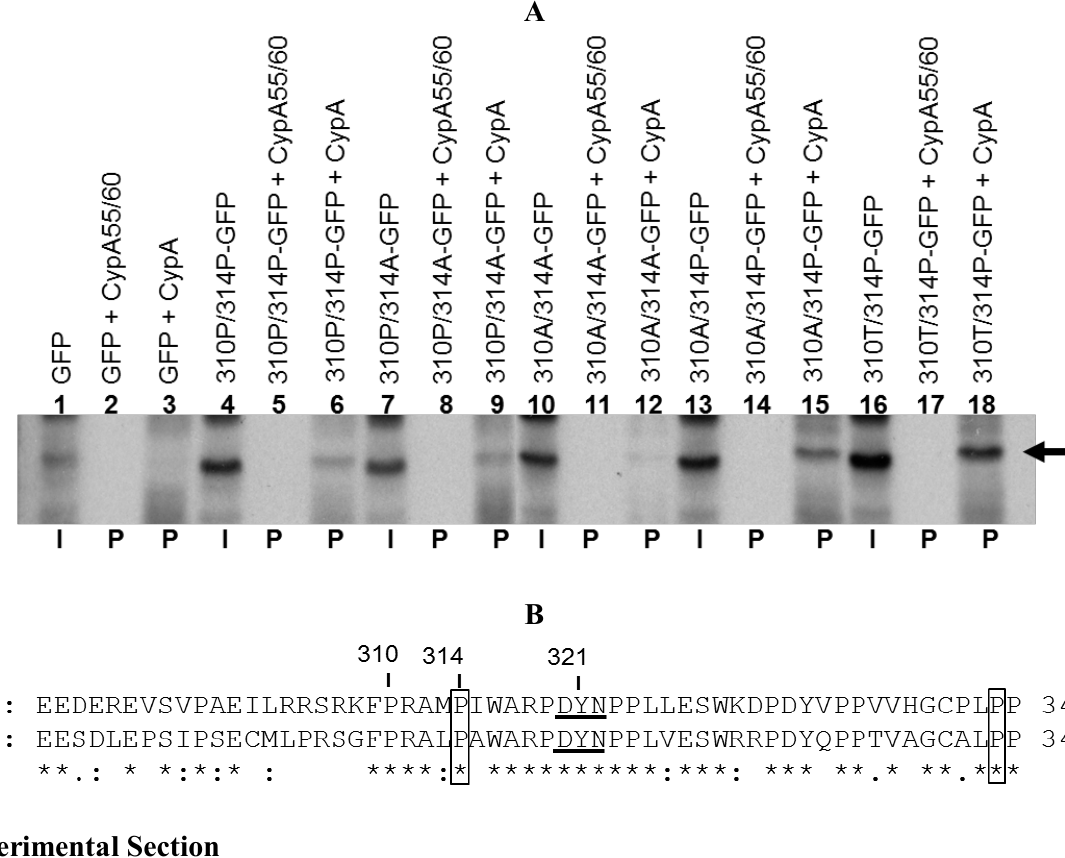
Figure 5. CypA binding analysis of a peptide containing Ala, Pro and Thr at position 310. ( A ) 35 S labeled proteins derived from NS5A peptide fused to the GFP coding sequences were incubated with either GST-CypA55/60 or with GST-CypA. The pulled-down complexes were resolved by SDS-PAGE and signal was detected by autoradiography. The arrow indicates expected size proteins (I = input (1/20th loaded); P = pull-down). ( B ) Alignment CypA binding region from genotype 1b and 2a. The highly conserved DYN region is underlined and amino acids of interests are numbered. In addition to P310 described in this study, the boxed residues were demonstrated previously to regulate the Alisporivir susceptibility in genotype 2a